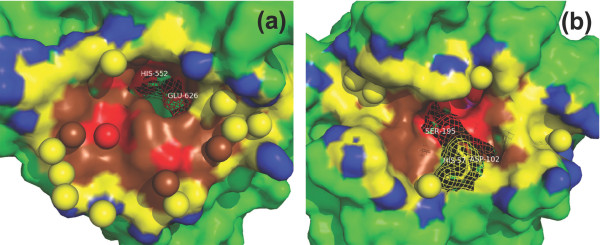
Two cases of protease-inhibitor interfaces. (a) The interface between a carboxypeptidase a2 (EC number: 3.4.15.1) and a metallocarboxypeptidase inhibitor ([PDB:1DTD], resolution: 1.65 Å, wetness: 0.055, rWBL: 0.998). (b) The interface between a beta-trypsin (EC number: 3.4.21.4) and its inhibitor ([PDB:2PTC], resolution: 1.9 Å, wetness: 0.029, rWBL: 0.954). The figures only show the enzyme part (in surface) and the interfacial water (in spheres). Non-interface part is colored green. In (a), there are 4 layers of nested-rings in interface: O0 (red), O1 (brown), O2 (yellow) and O3 (blue). In (b), there are 5 layers of nested-rings: O0 (magenta), O1 (red), O2 (brown), O3 (yellow) and O4 (blue). Active site residues [29] are shown in sticks and mesh.